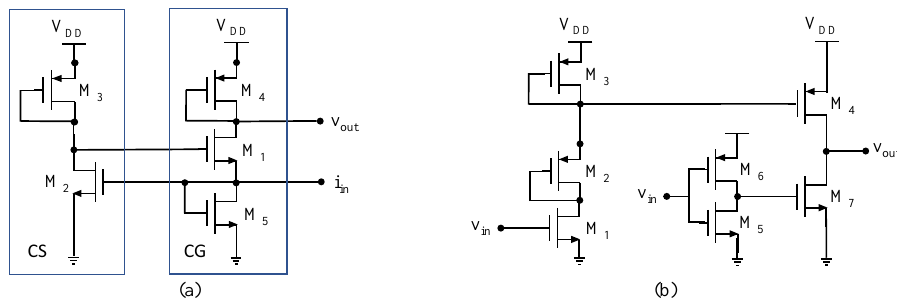
Figure 7. Schematic of ( a ) the TIA amplifier and ( b ) the high-voltage pulser.